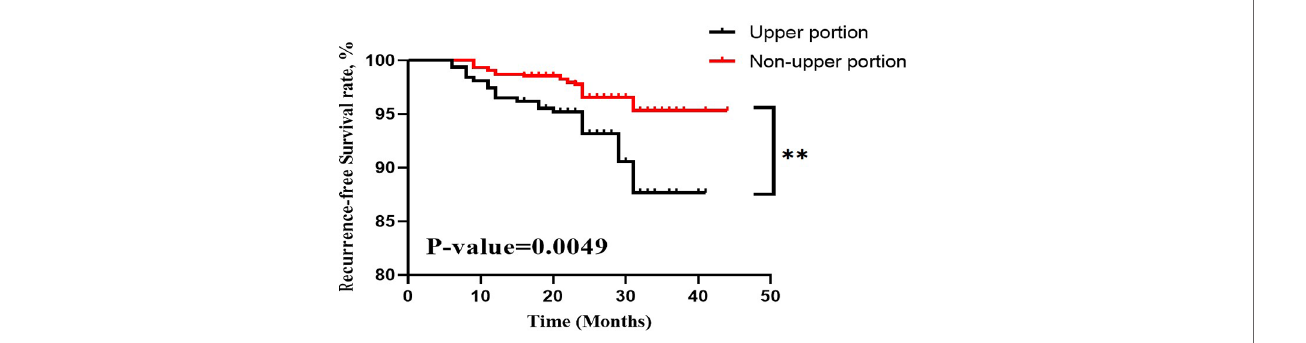
FIGURE 1 | RFS curves of PTC patients strati fi ed by tumor located in upper portion or not. RFS, recurrence-free survival; PTC, papillary thyroid carcinoma. **, p-value